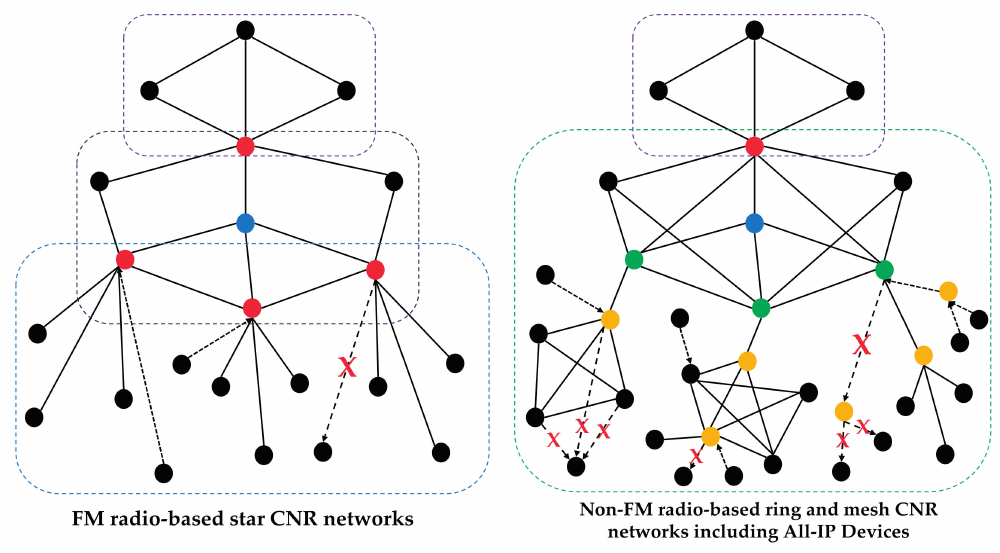
Figure 9. VMF–CNR network architecture based on FM radio and All-IP next-generation